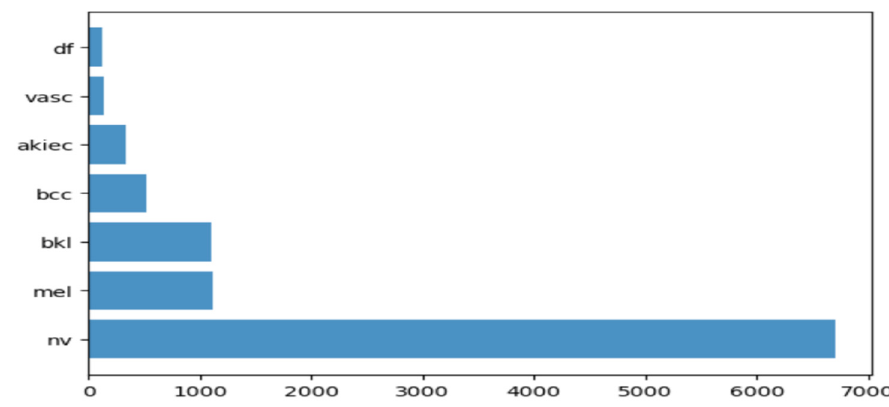
Figure 2. Occurrence of images of each type of skin cancer.